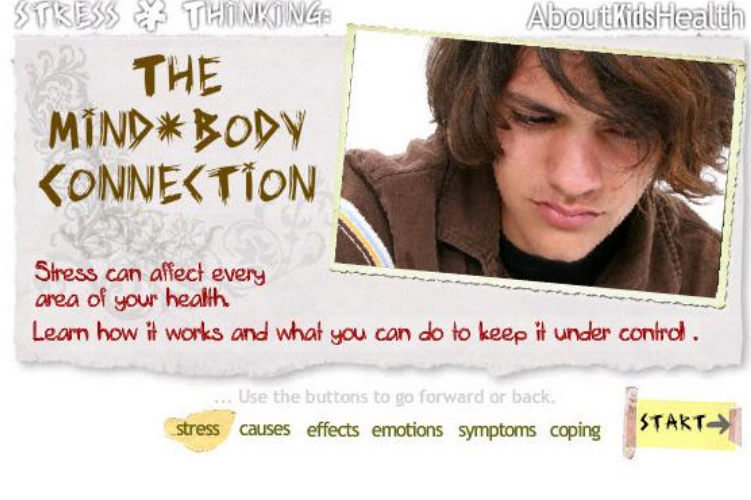
Figure 3. Example of a “stress and thinking” click through